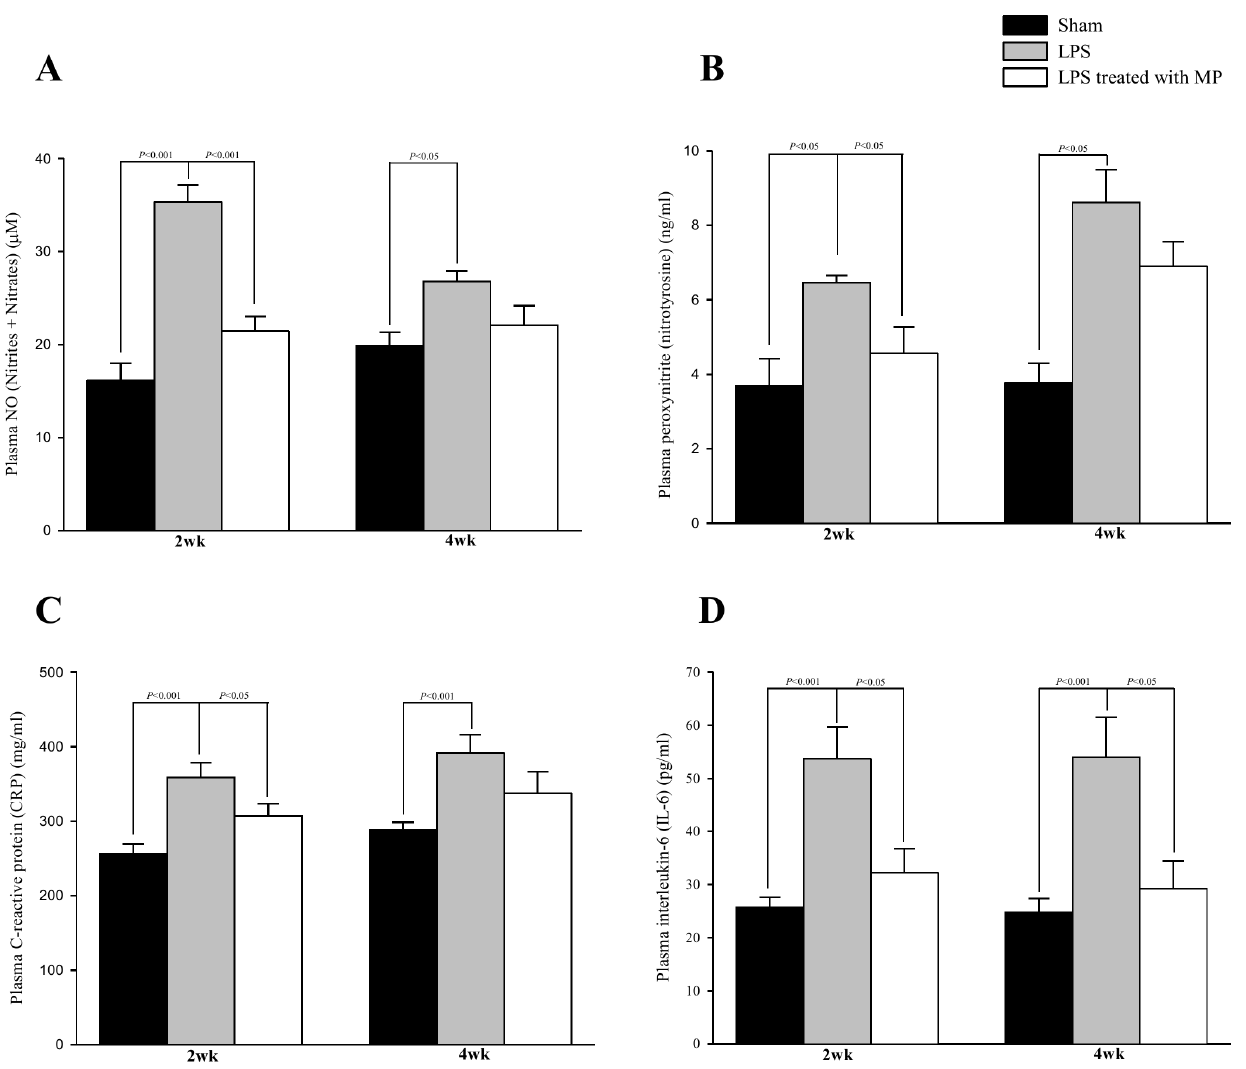
Figure 4. Effects of LPS and MP on the plasma levels of NO (Nitrites + Nitrates) (A), Peroxynitrite (nitrotyrosin) (B), CRP (C), and IL-6 (D). Data are expressed as mean 6 s.e. LPS, lipopolysaccharide; MP, methylprednisolone; NO, nitric oxide; CRP, C-reactive protein; IL-6, interleukin-6. ( n =10 in each group).